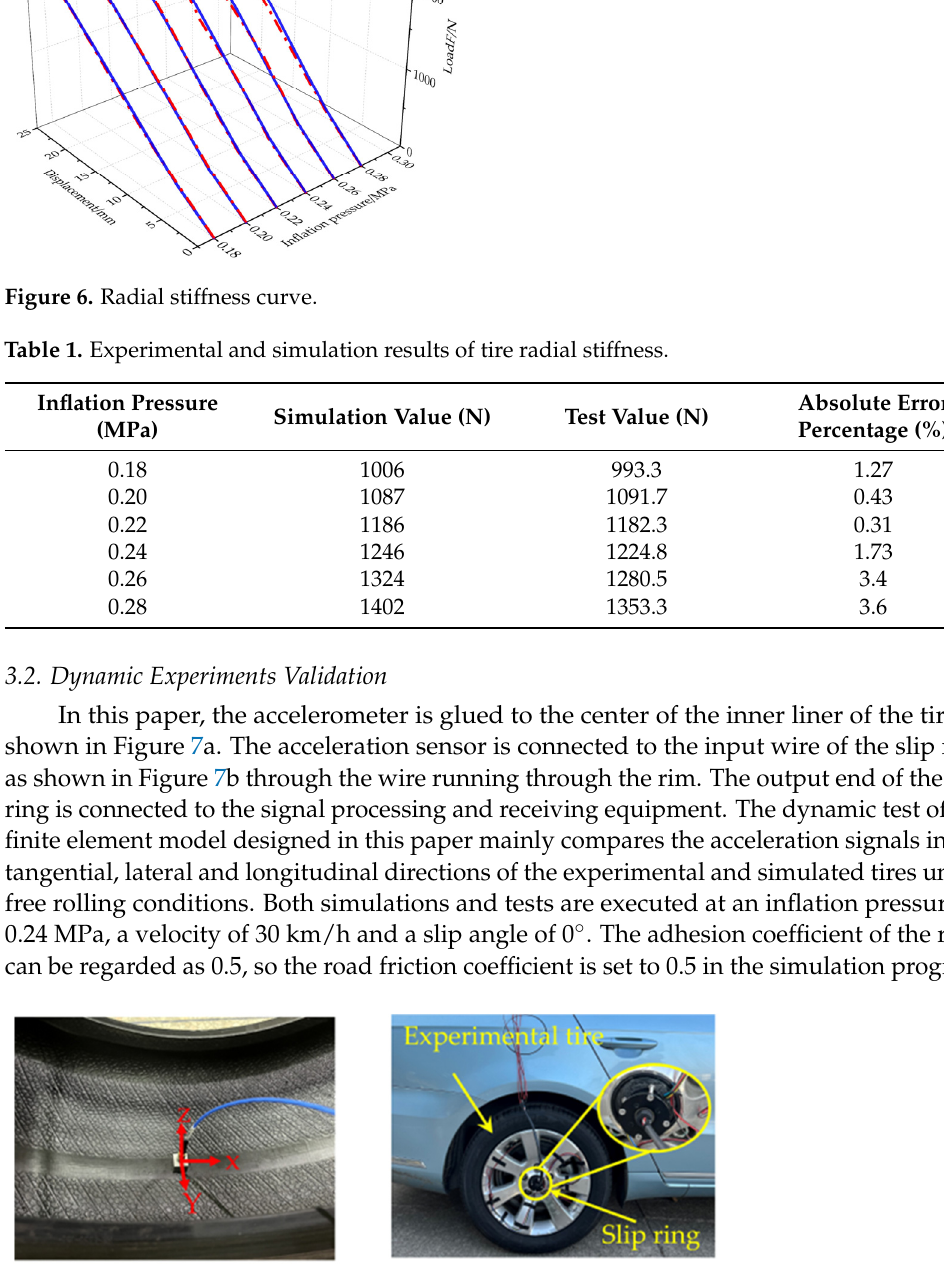
Figure 8. Comparison of experimental and simulation results. 4. Simulation Results and Discussion 4.1. The Influence of Different Inflation Pressures on the Contact Patch In this section, the tire load is 3000 N, the speed is 30 km/h and the tread wear is 0 mm, and the range of inflation pressure is [0.181 MPa, 0.241 MPa]. It is worth noting that the paper mainly studies the length of the longitudinal contact path of the tire, which is read by the Path function in the ABAQUS software. The red line path shown in the 0.181 MPa contact pressure (cpress) cloud diagram, as shown in Figure 9, is the path of the path node. The following also mainly studies the variation law of the contact pressure on this path. The maximum cpress is mainly distributed in the contact area center of the tire. When the inflation pressure is 0.181 MPa, the maximum cpress is 0.3156 MPa, and when the inflation pressure is 0.241 MPa, the maximum contact pressure is 0.398 MPa, as shown in Figure 9. When the inflation pressure is 0.181 MPa, the ground contact shape of the tire is similar to a rectangle, the length of the rectangle in the longitudinal and transverse di- rections decreases with the increase of inflation pressure, the shape of the contact area is approximately oval when the inflation pressure is 0.241 MPa as shown in Figures 9 and 10. The reason is that the increase of the inflation pressure leads to the increase of the overall stiffness of the tire. It can be seen from Figures 9 and 11 that the change of inflation pressure does not cause the change of cpress distribution; however, the cpress value in the central area of the contact patch increases with the increase of inflation pressure. This